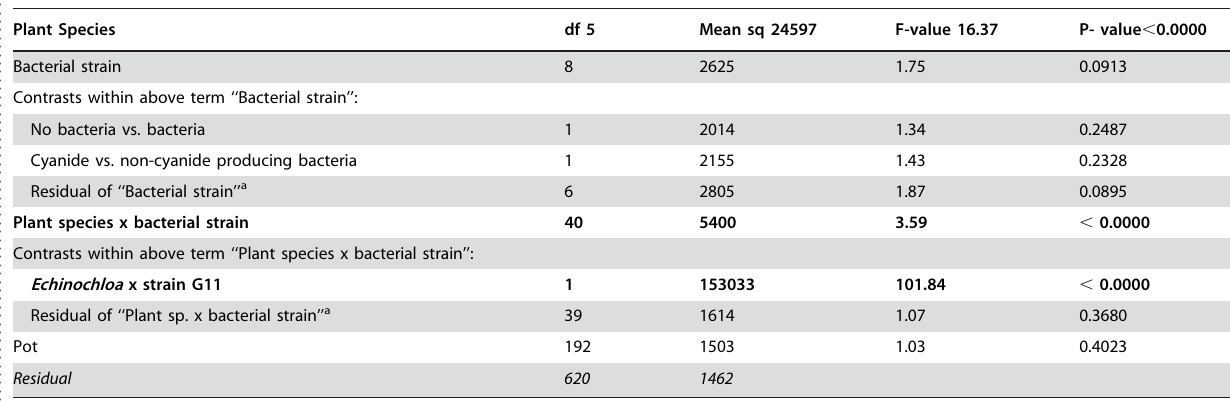
Table 2. ANOVA-table for aboveground biomass in the host-plant selectivity experiment. .. ... .... ... ... .... ... ... .... ... ... .... ... ... .... ... ... .... ... ... .... ... ... .... ... ... .... ... ... .... ... ... .... ... ... .... ... ... .... ... ... .... ... ... . Plant